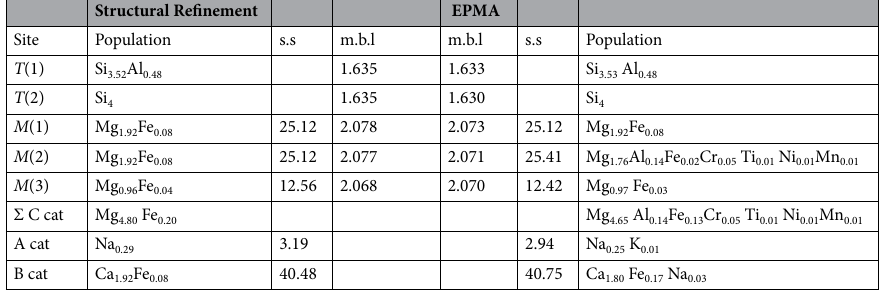
Table 1. Comparison between site populations (a.p.f.u), site scattering (s.s., a.p.f.u) and mean bond length (m.b.l., ) values, derived from structural refinement and EPMA based recalculations. M.b.l. values for T sites in EPMA based recalculations were reported according to Oberti et al . 26 Å